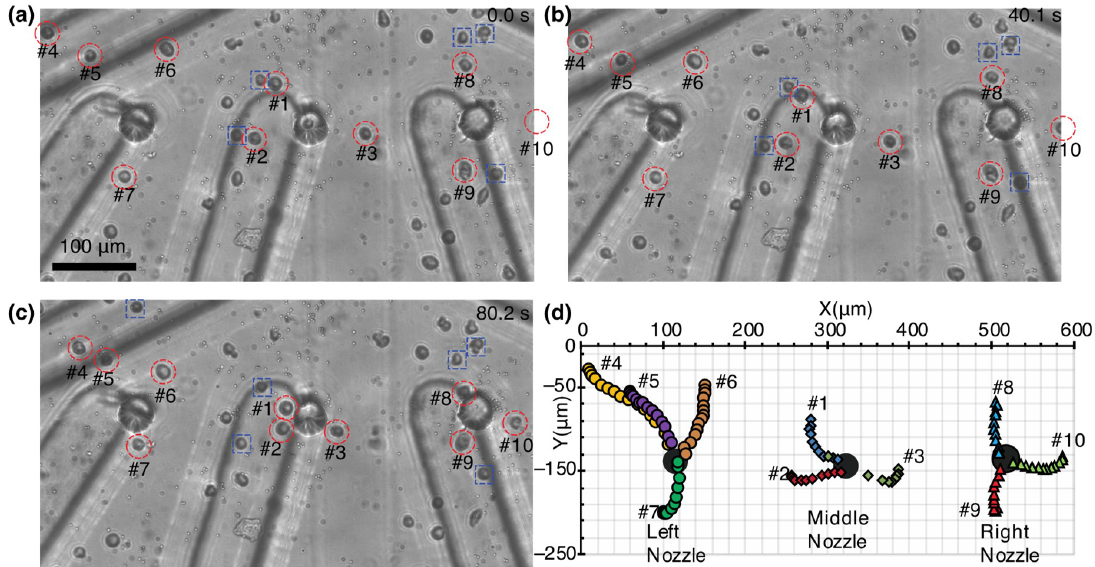
Figure 6. Suction of 10 cells using an electrokinetic pump near three nozzles (100 kHz, 10 V pp , V DC − 4 V). ( a – c ) Time-lapse images of cell suction. Voltage was applied at 0 s and the flow was continuously generated. The 10 cells are circled by a red dashed line and attracted cells are boxed by a blue dashed line. ( d ) Trajectories of the aspirated 10 cells.